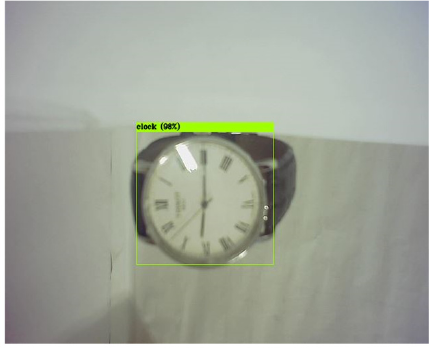
Figure 8. An example of the target recognition experiment, in which the quadrangle is the recognition frame and 98% is the confidence.